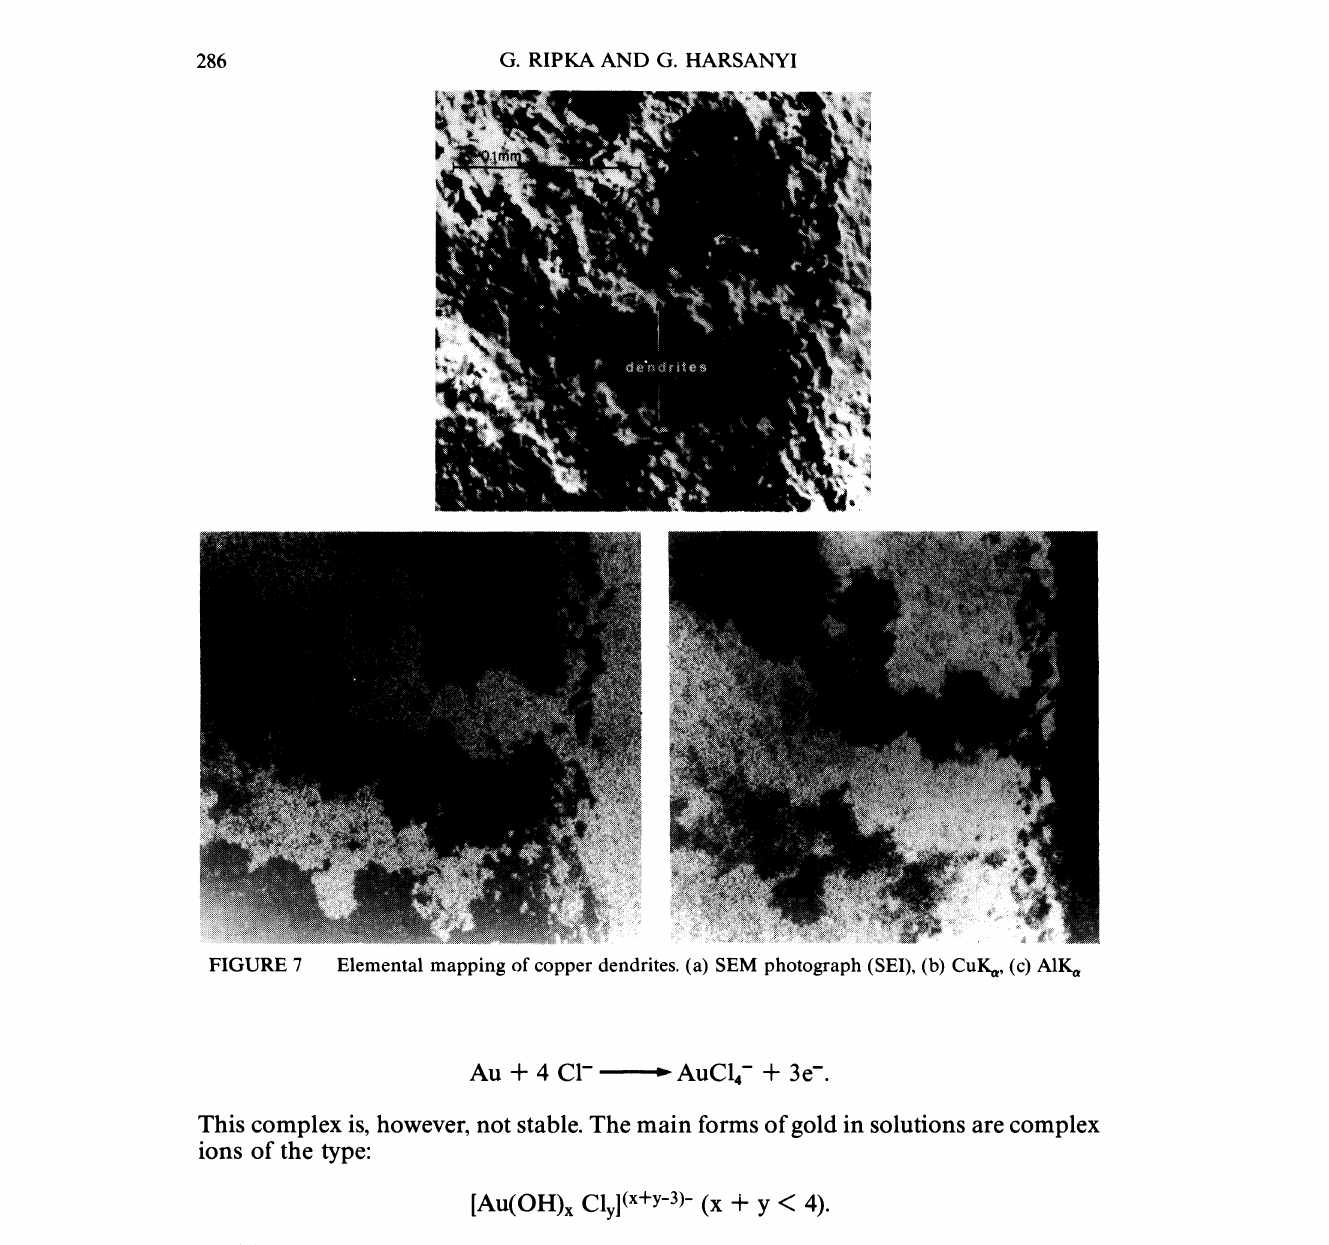
FIGURE 7 Elemental mapping of copper dendrites. (a) SEM photograph (SEI), (b) CuK (c) A1K - Au + 4 C1- AuC14- +